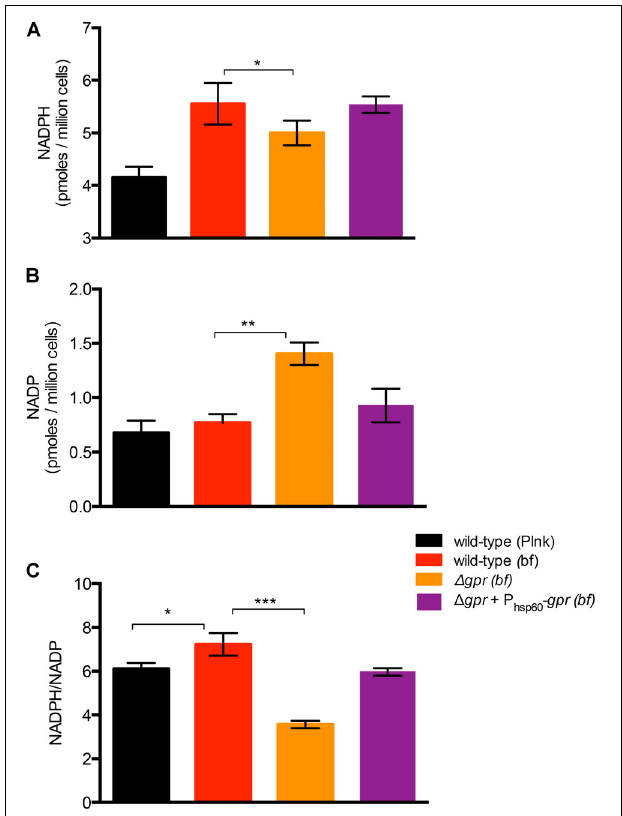
FIGURE 5 | Role of gpr in maintenance of redox homeostasis of M. smegmatis. (A,B) Levels of oxidized (NADP) form of nicotinamide adenine dinucleotide phosphate in biofilms of wild-type, (cid:49) gpr and the complemented strains cultured in normal Sauton’s medium. (C) Ratio of NADPH to NADP calculated from (A,B) . Data represent mean of three biologically independent experiments ∗ , ∗∗ , and ∗∗∗ indicate p ( t -test) < 0.05, 0.01, and 0.001,